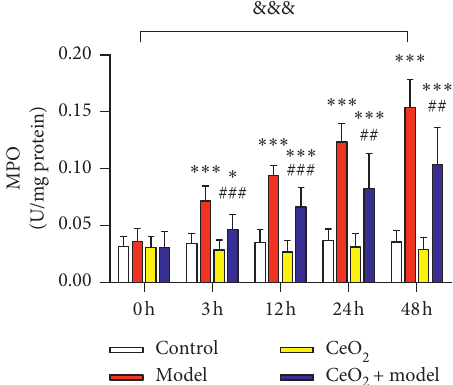
Figure 5: MPO activity changes in peritoneal tissue of rats in each group. Compared with the control group, ∗ P < 0 . 05, ∗∗∗ P < 0 . 001; differences within the model group, &&& P < 0 . 001; compared with the model group, ## P < 0 . 01, ### P < 0 .